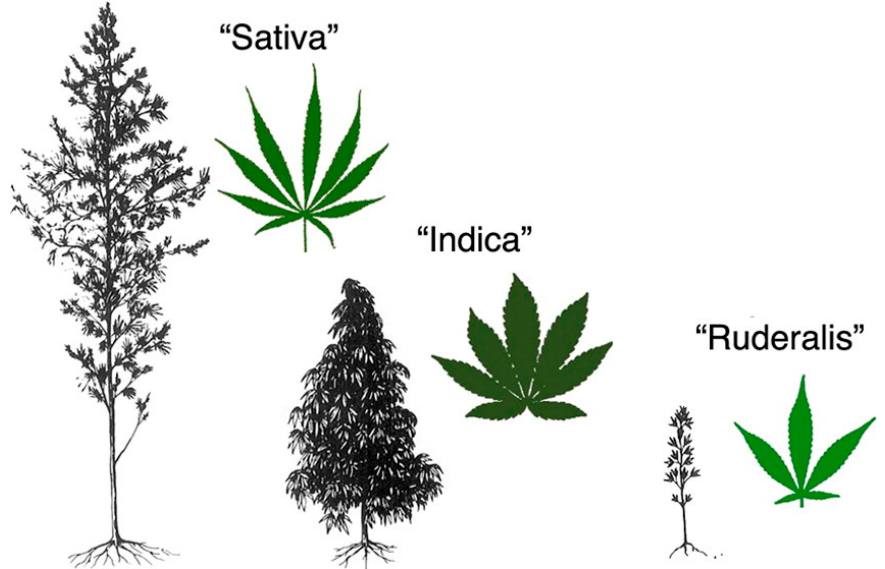
Figure 1. Morphological differences among varieties of Cannabis sativa species, image from John M. McPartland. Cannabis and Cannabinoid Research. Dec 2018.203-212. http://doi.org/10.1089/can.2018.0039.